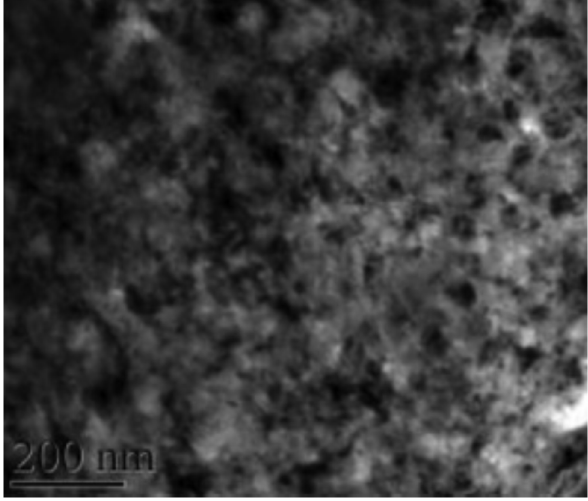
Figure 6 . Bright ‐ field TEM indicating surface nanocrystallization in 304 SS after three LSP passes [87].